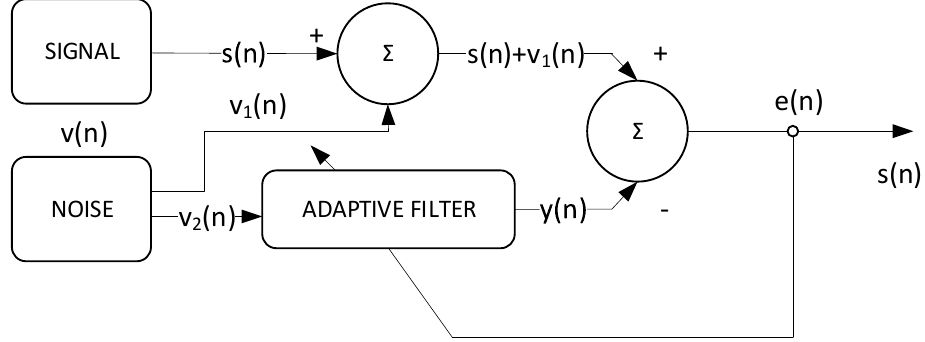
Figure 18. Adaptive noise cancellation theoretical configuration.